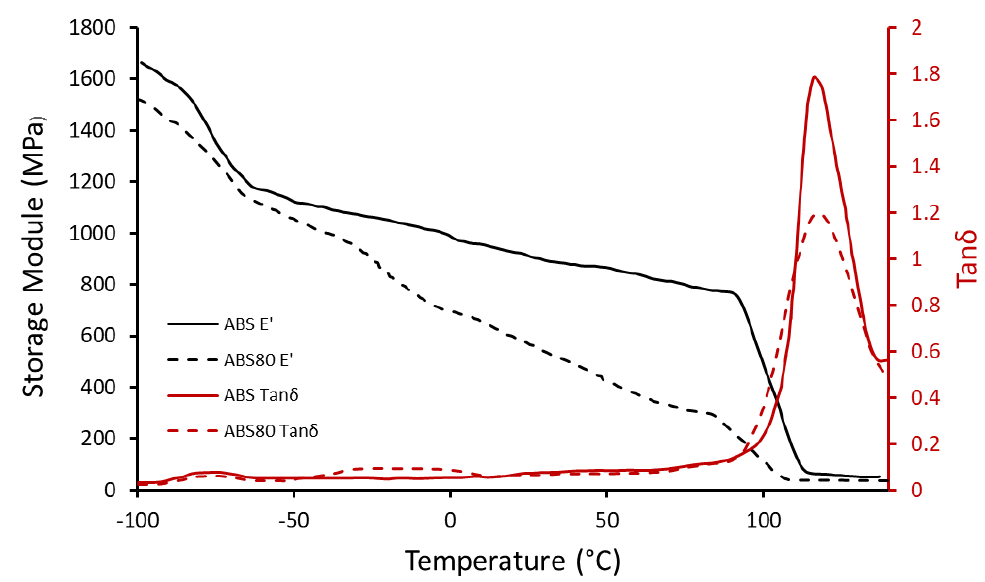
Figure 2. Storage module and tan δ of TPU.